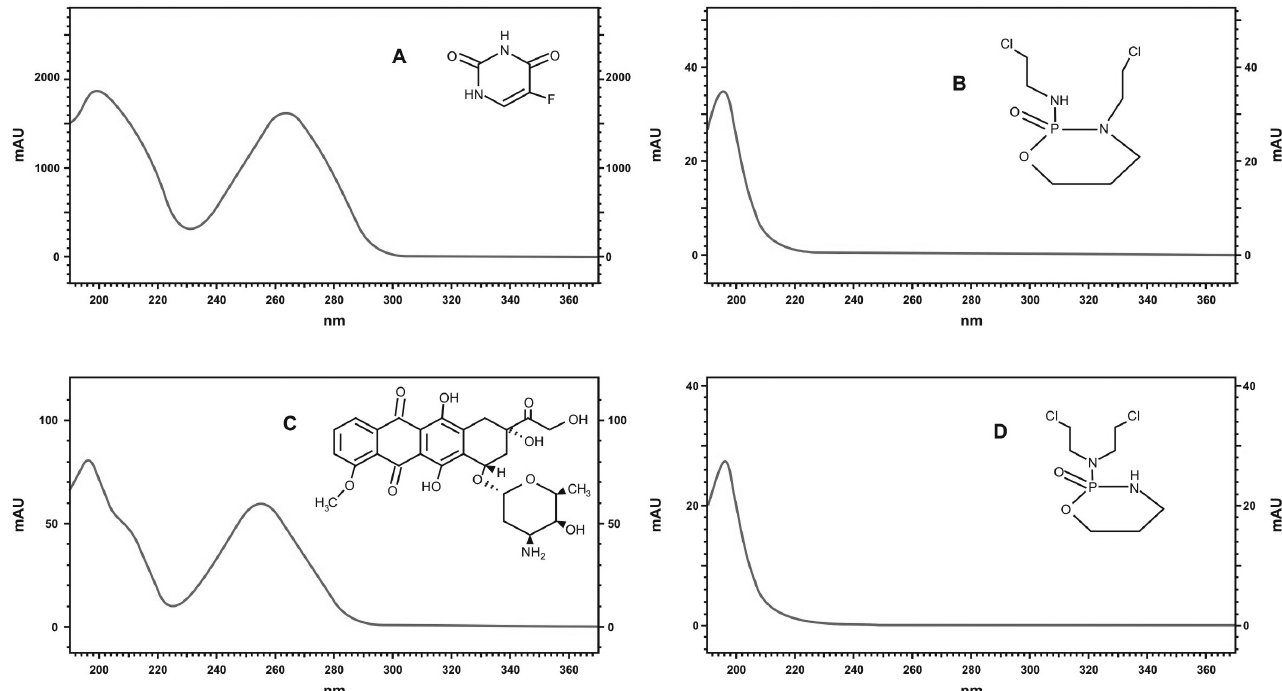
FIGURE 1 - Spectra and chemical structures of antineoplastic drugs: (A) fluorouracil, (B) ifosfamide, (C) doxorubicin and (D)